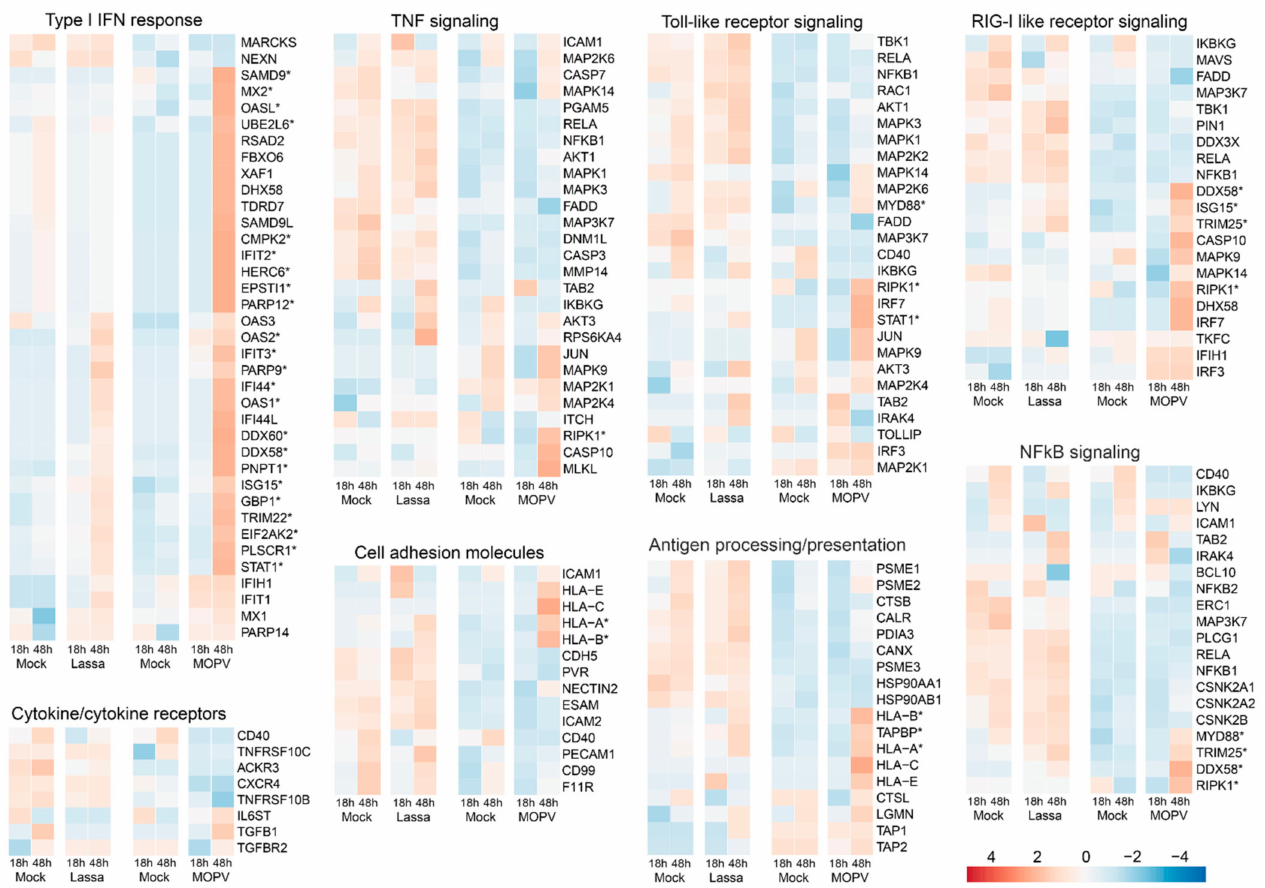
Figure 7. Heatmaps of protein abundance of different protein sets in HUVEC cell extracts. DA proteins are highlighted with asterisks. The average quantity is indicated on the